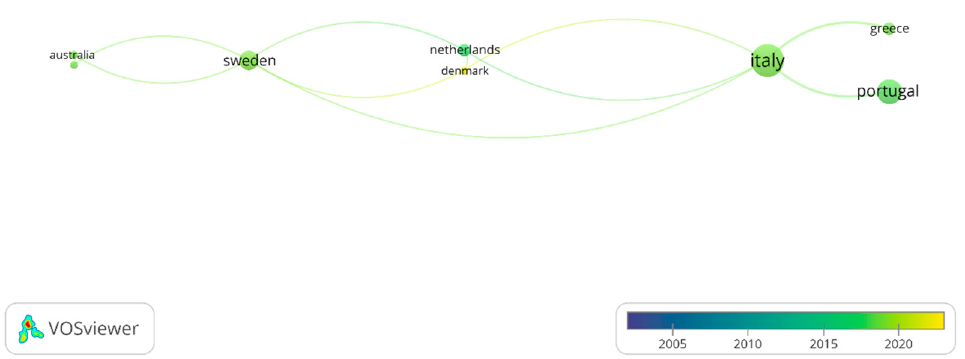
Figure 6. Countries network in the topic (overlay visualization mode). Only the connected countries are shown (2003–2022).